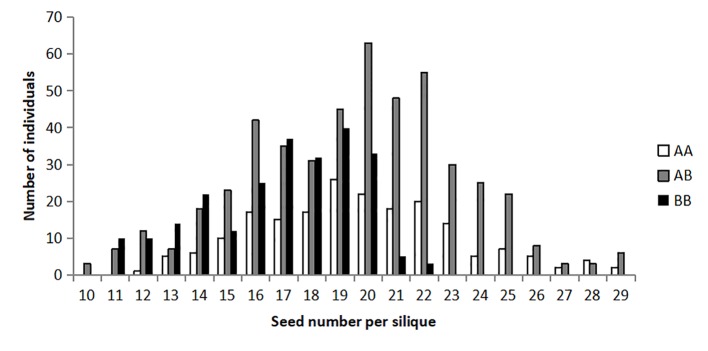
Frequency distribution of seed number per silique in the BC4F2 population. The horizontal axis represents the trait value of seed number per silique. The vertical axis represents the number of individuals. The three types of genotype are represented by the three column colors, as shown in the legend.